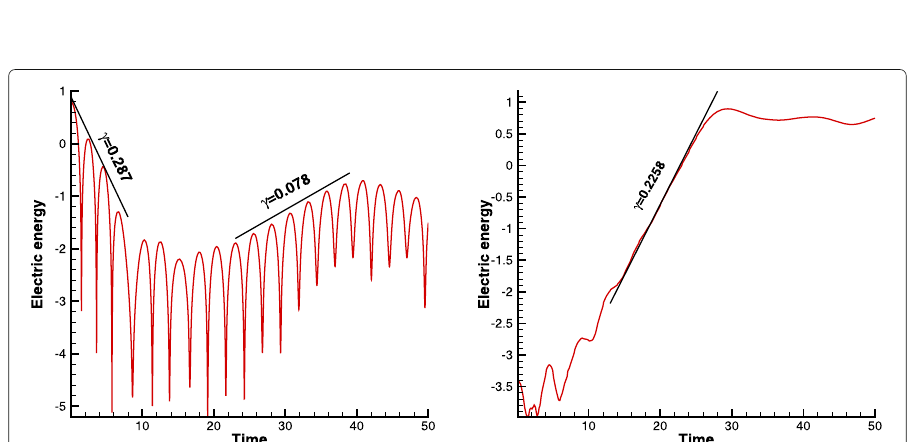
Fig. 4 Left figure shows the result of nonlinear Landau damping, Red line shows the time evolution of the electric energy calculated by the UGKWP method, and the black lines show the reference solutions. Right figure shows the result of two stream instability. Red line shows the time evolution of the electric energy calculated by the UGKWP method, and the black line gives the theoretical prediction of the electric energy increase